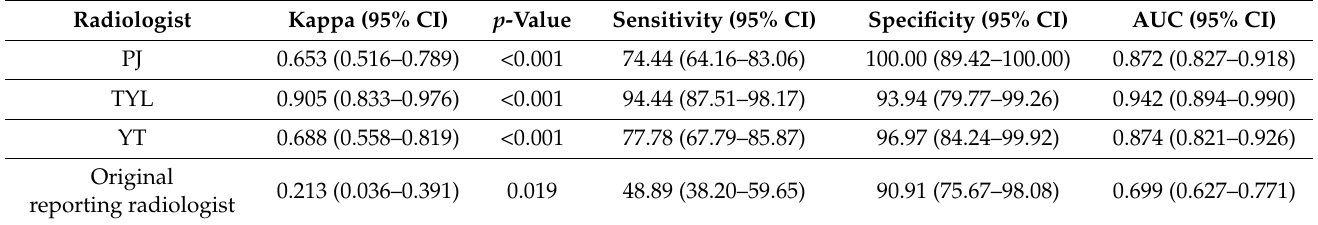
Table 7. Radiologist sensitivity, specificity, and AUCs for two-grade (normal/low versus high-grade) MESCC per CT